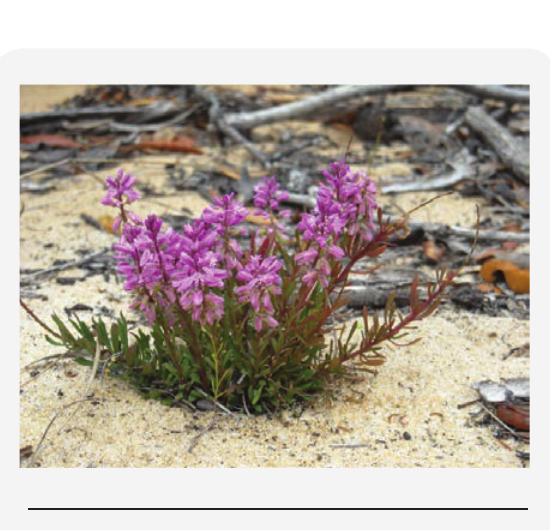
Figure 8. The showy, aboveground chasmogamous fl owers of Polygala lewtonii. Results of genetic analyses show that the showy fl owers do not show high rates of outcrossing and that most reproduction arises from self-fertilization or inbreeding. Photo by Carl